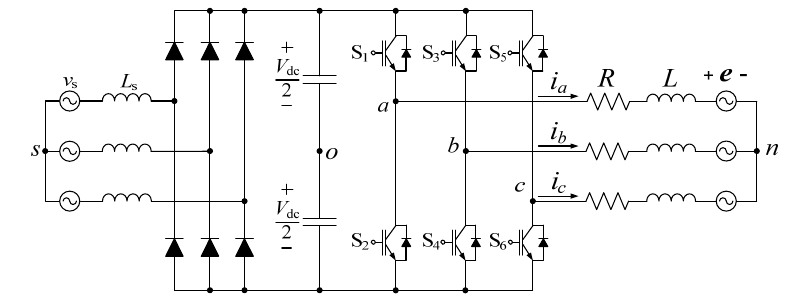
Figure 1. Voltage source inverters (VSI) with a diode rectifier.